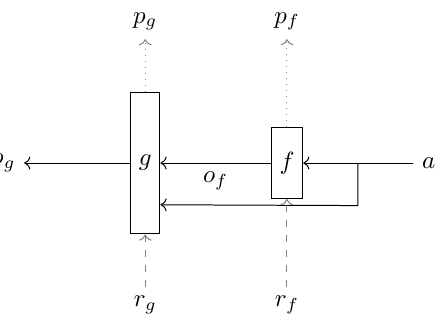
Figure 5: The composition pattern of f ( d -NI) and g ( d -SNI) derived from [CPRR14].